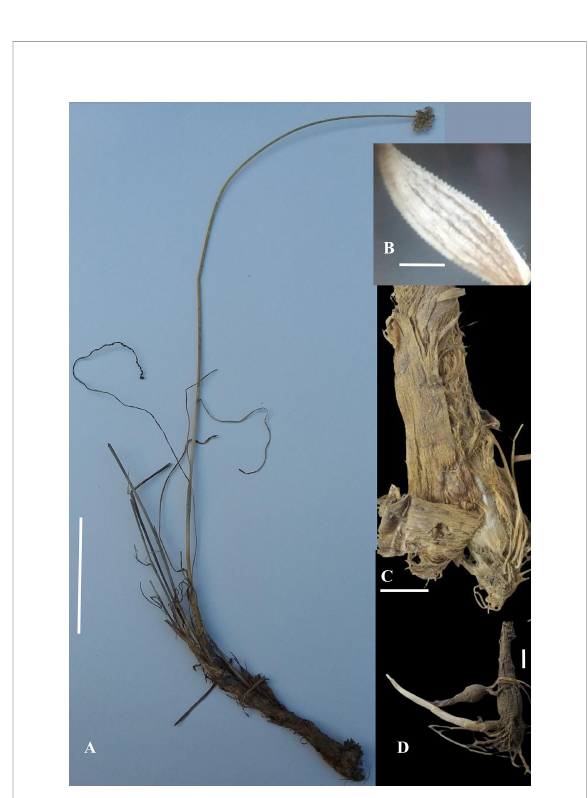
FIGURE 2 Allium sulaimanicum : (A) whole plant (scale bar: 8 cm) (B) Leaf in enlargement under a stereomicroscope (scale bar: c. 1 mm) (C) Bulb with outer coats brown coriaceous at the extreme base and otherwise fi brous with strips (scale bar: 6 mm) (D) Bulb with long rhizome (scale bar: 6 mm) (Photos by Nazar Khan except Fig. 2A by Amir Sultan and Fig. 2C by Muhammad